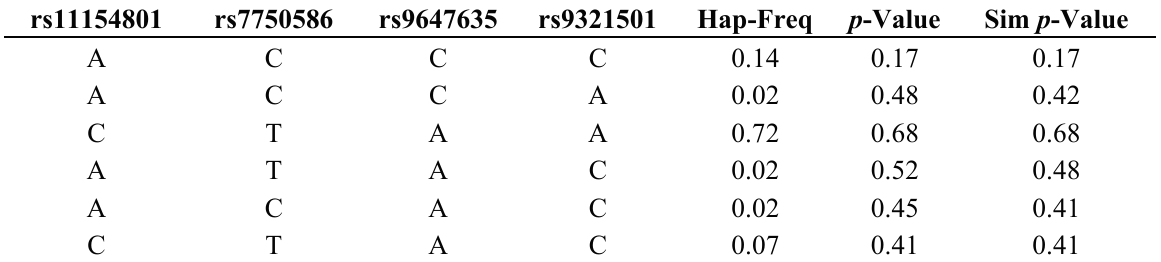
Table 4. Haplotype analyses on the improvement of the PANSS total